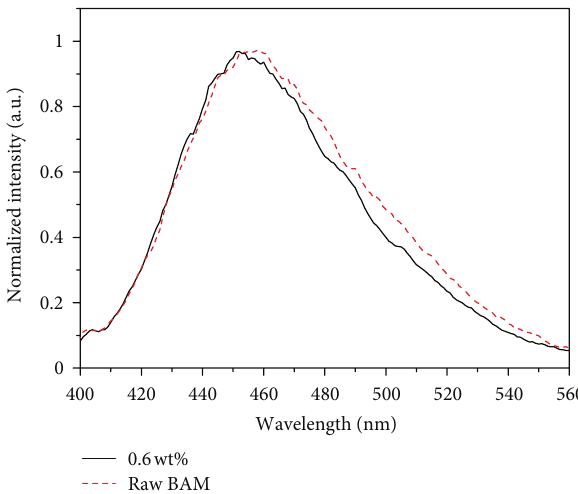
Figure 6: Emission spectra of 0.6 wt% CaF 2 -coated BAM and raw = 147 nm). BAM after 600 ∘ C heat treatment ( 𝜆 ex Table 2: The chromaticity coordinates of the 0.6 wt% CaF 2 -coated BAM and raw BAM. Before heat treatment After heat